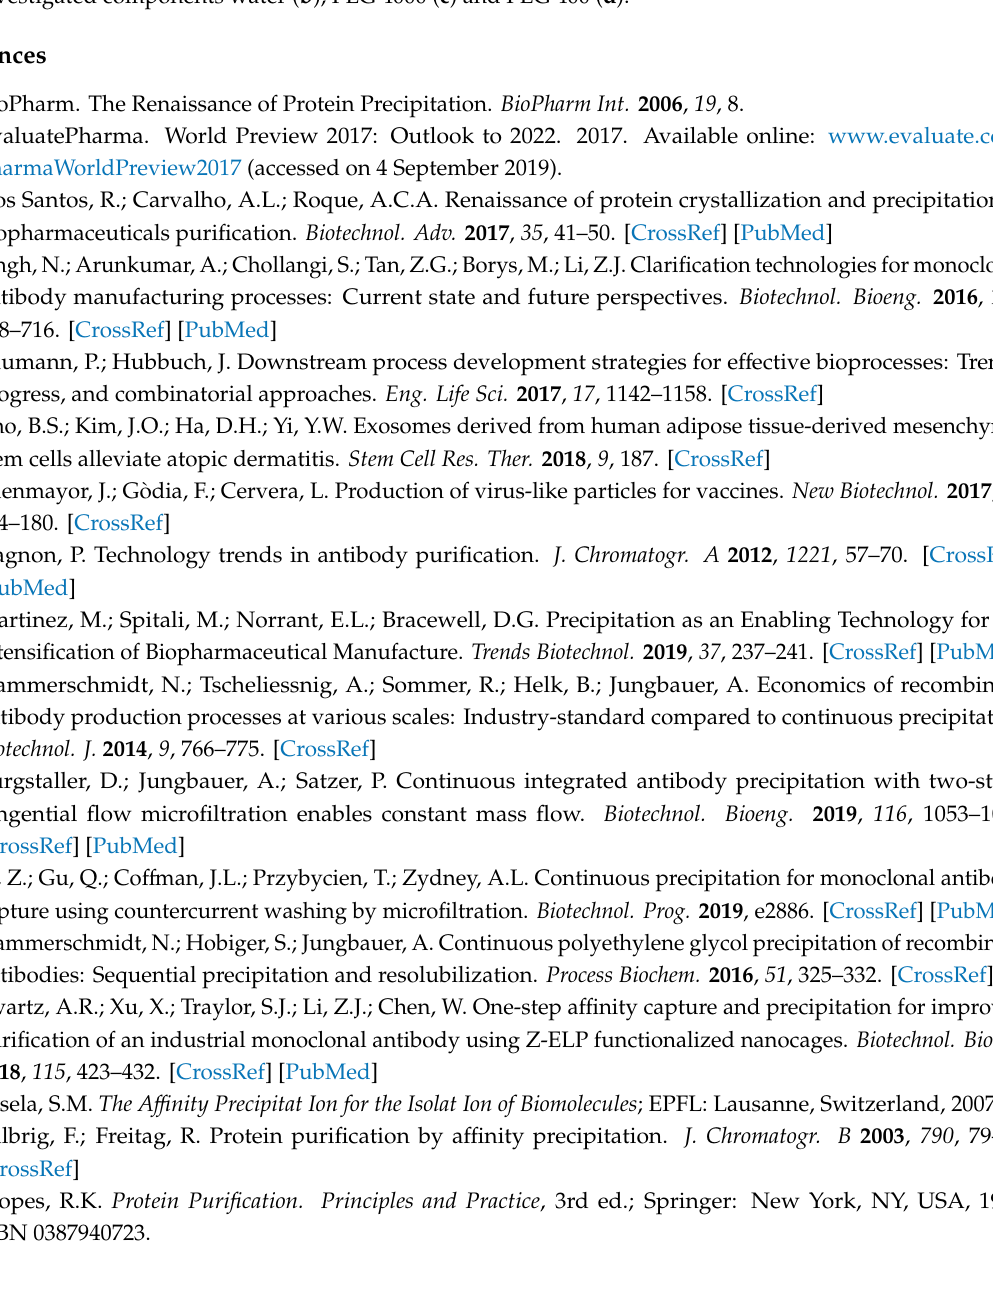
Figure A1. Model output: ( a ) describes the relation between principle components and variance of spectral data. Plots ( b–d ) indicate the model accuracy of predicted vs. reference data for the three investigated components water ( b ), PEG 4000 ( c ) and PEG 400 ( d ).